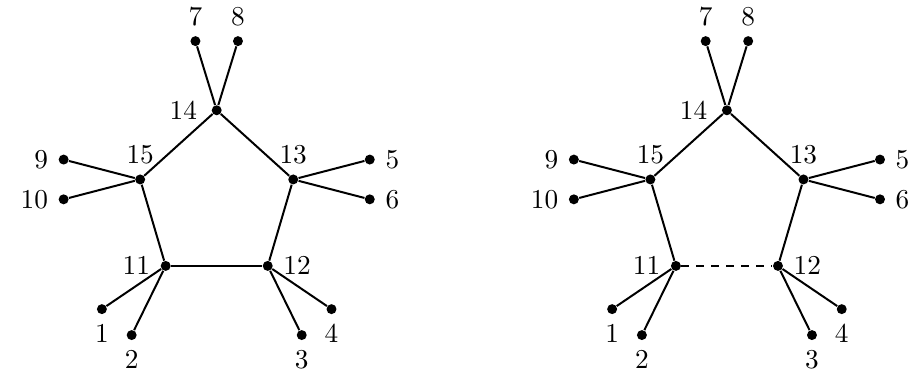
Fig. 1: Two non-equivalent signatures on U ( 4 , 5 ) . All edges, except the dashed one, are positively